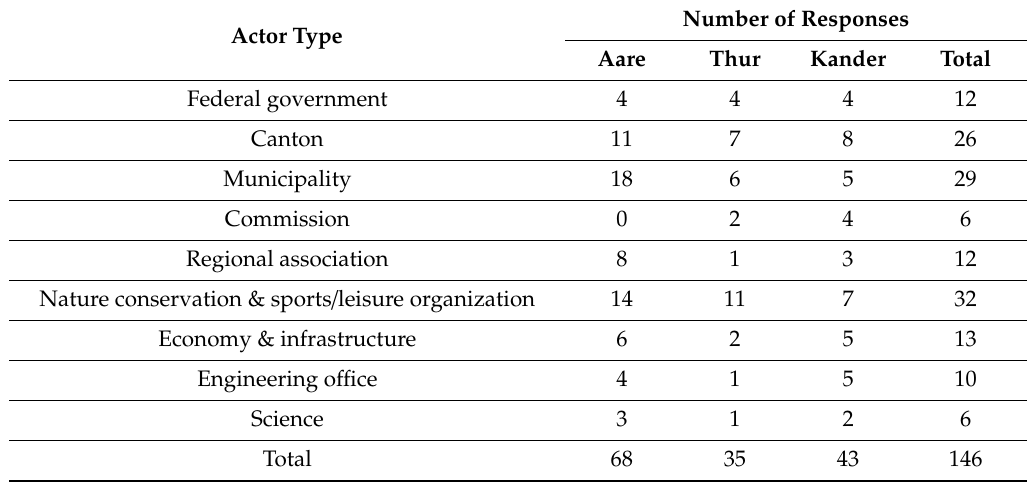
Table 1. Overview of the actor sample with the number of survey responses per actor type. Actor Type